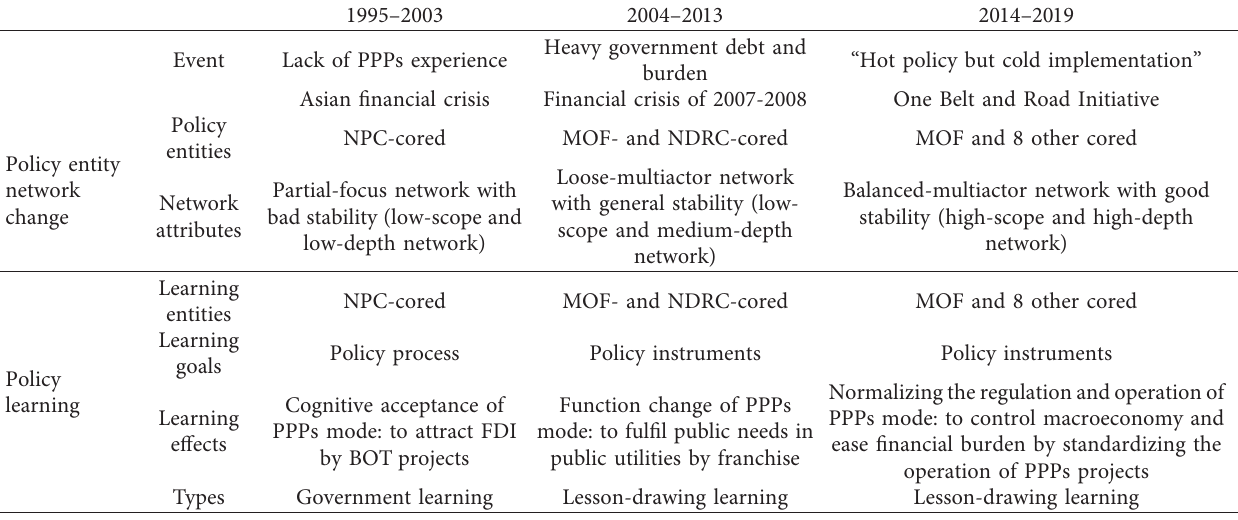
Table 6: PPPs policy network entity network change and policy learning in China from 1995 to